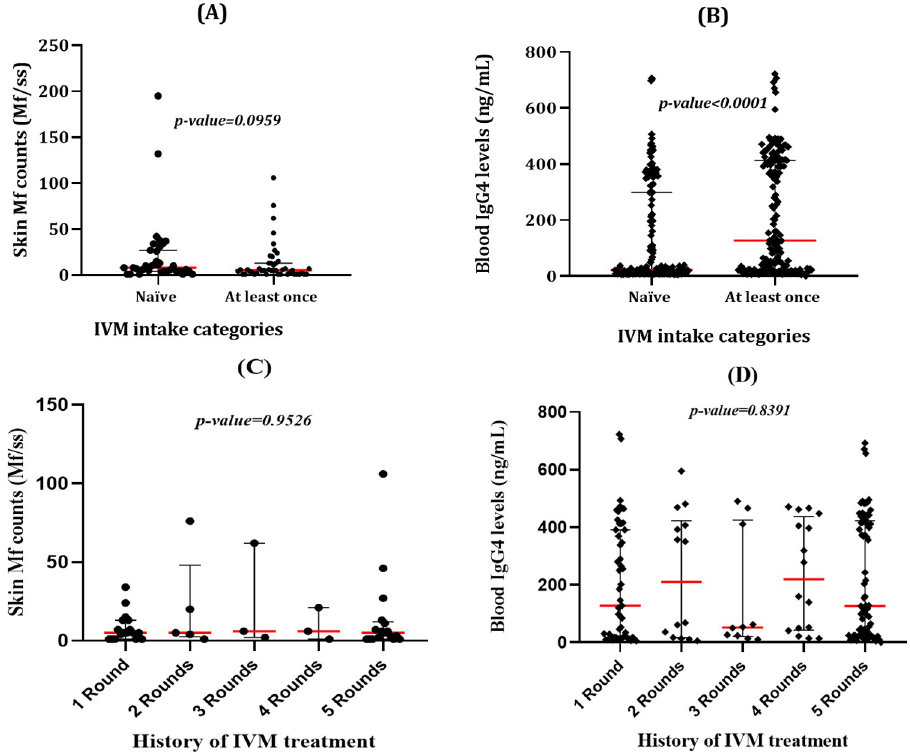
Fig 3. Distribution of Mf counts and IgG4 concentration according to IVM intake history. (A) Comparison of skin Mf between IVM na ï ve and individuals who have taken IVM at least once. (B) Comparison of IgG4 concentration between IVM na ï ve and individuals who have taken IVM at least once. (C) Comparison of IgG4 concentration according to the number of rounds IVM received during the last 5 years. (D) Comparison of skin Mf according to the number of rounds IVM received during the last 5